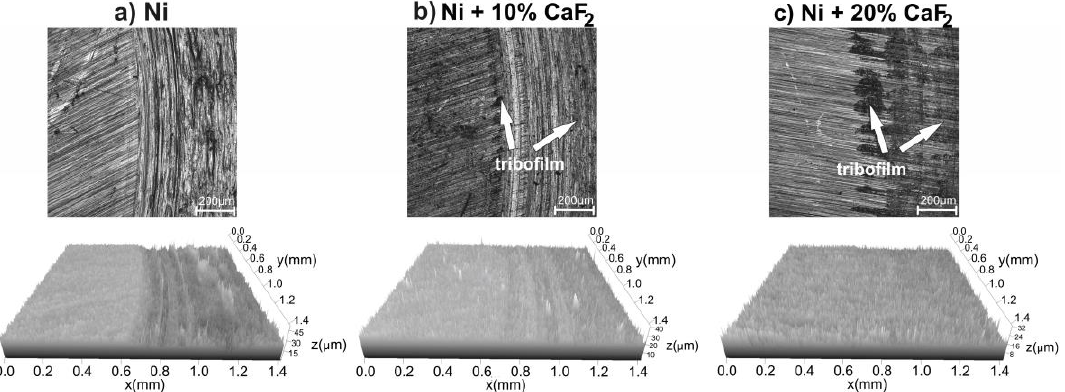
Figure 6. Stereometrics profiles of counter-specimens mated with produced sinters, after wear test at 23 °C.